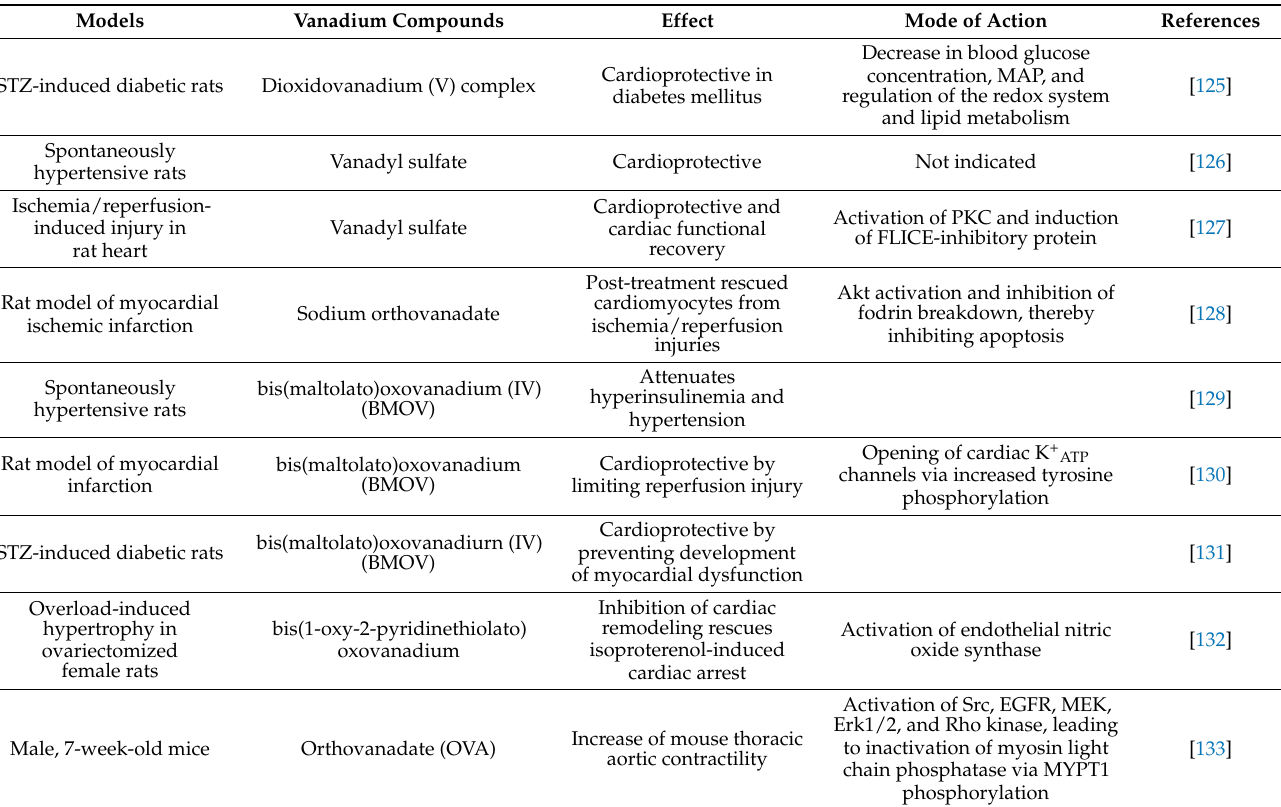
Table 1. Cardioprotective effects of some reported vanadium